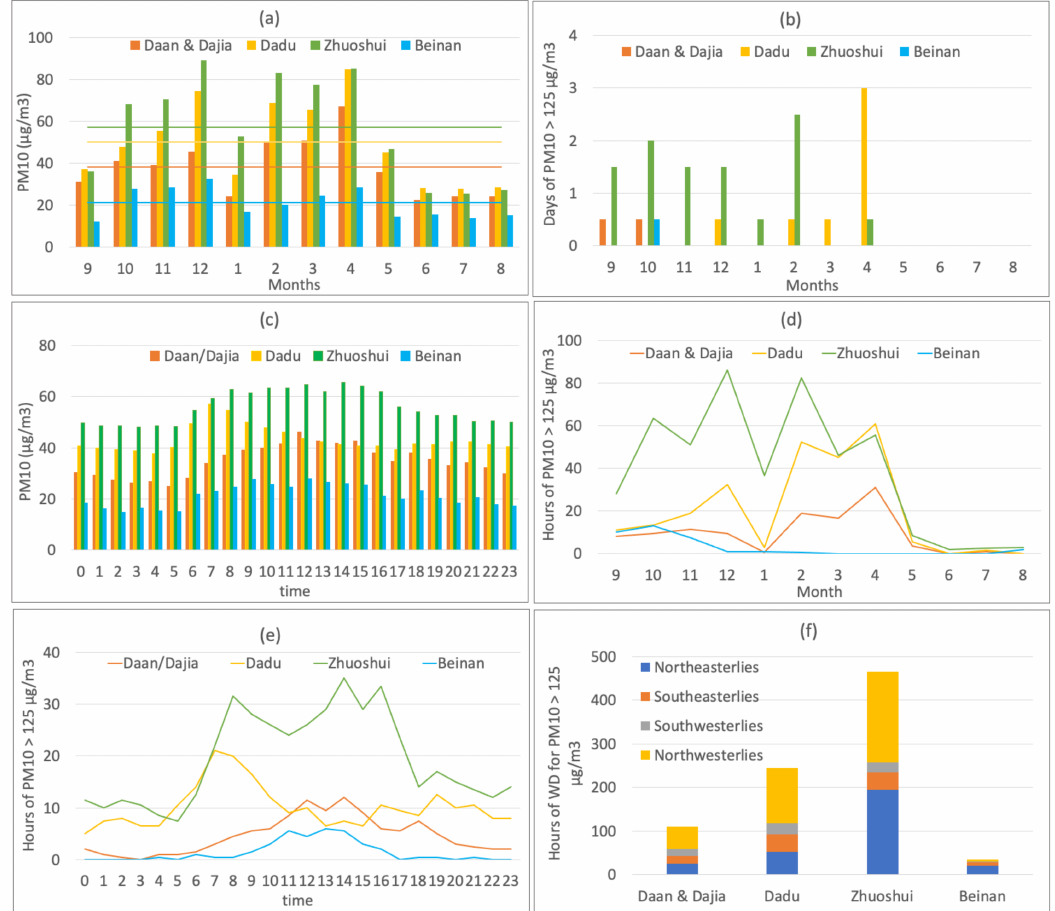
Figure 3. Summary from Figure 2, ( a ) monthly average PM 10 concentration, ( b ) daily counts of PM 10 greater than 125 µ g m − 3 in each month, ( c ) annual average PM 10 concentration in each hour, ( d ) hourly counts of PM 10 greater than 125 µ g m − 3 in each month, ( e ) hourly counts of PM 10 greater than 125 µ g m − 3 in each hour, and ( f ) hourly counts of wind directions per year for hourly PM 10 greater than 125 µ g m − 3